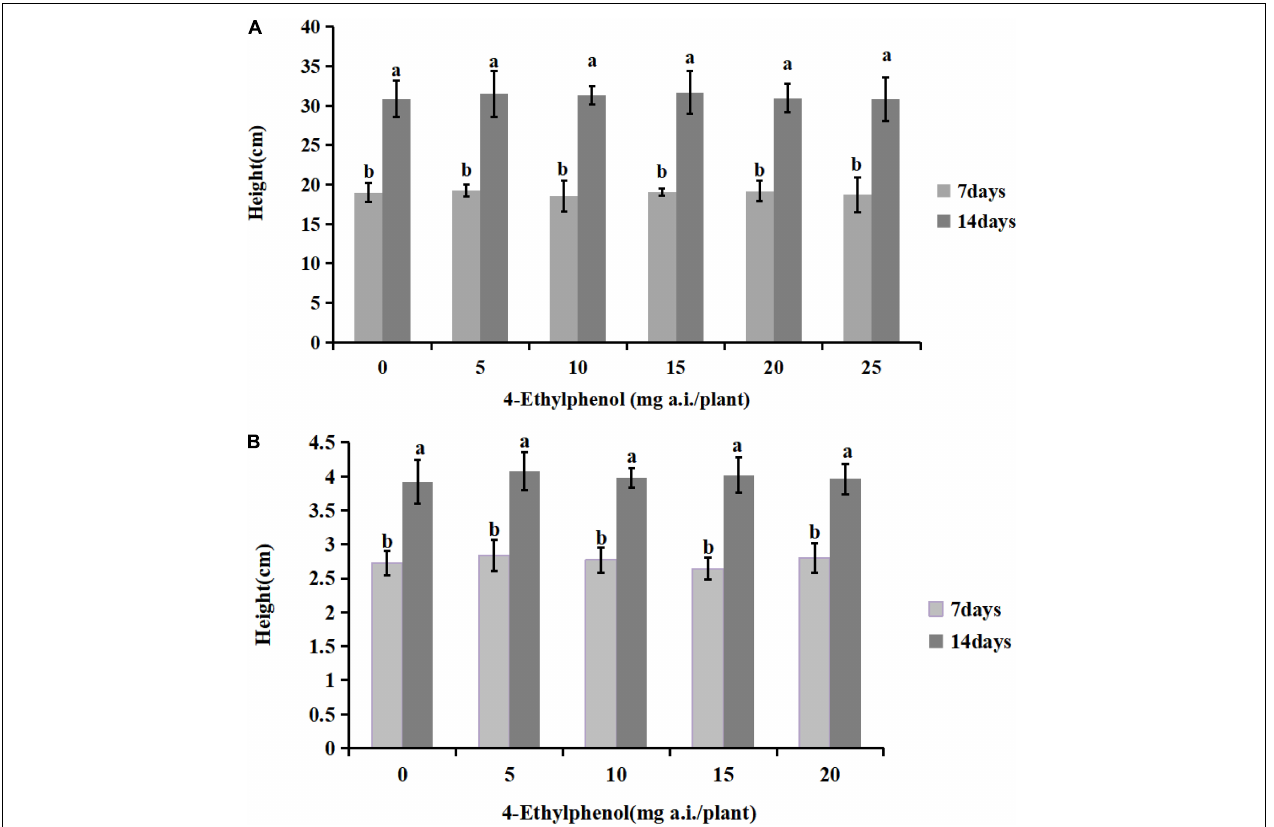
FIGURE 5 | Effects of 4-Ethylphenol on soybean (A) and tobacco (B) height. Data are the mean ± S.E. from three replicates per treatment.